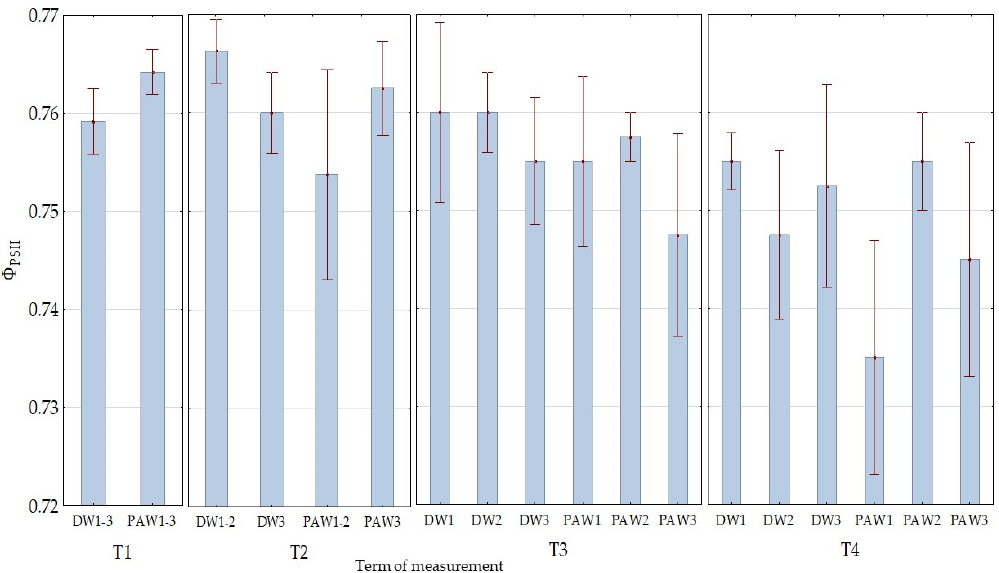
Figure 3. Effect of PAW on quantum yield of PSII ( Φ PSII ) over time. Lack of lowercase lettering indicates no significant differences between the mean values (n = 8). Intervals present the mean standard error (SE).